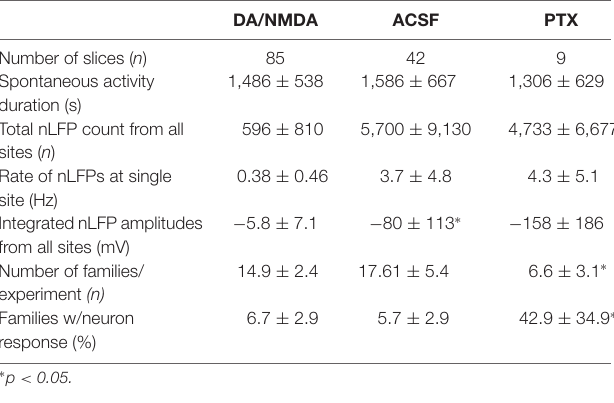
TABLE 1 | Comparison of in vitro population activity for the three different recording conditions (mean ± SEM).